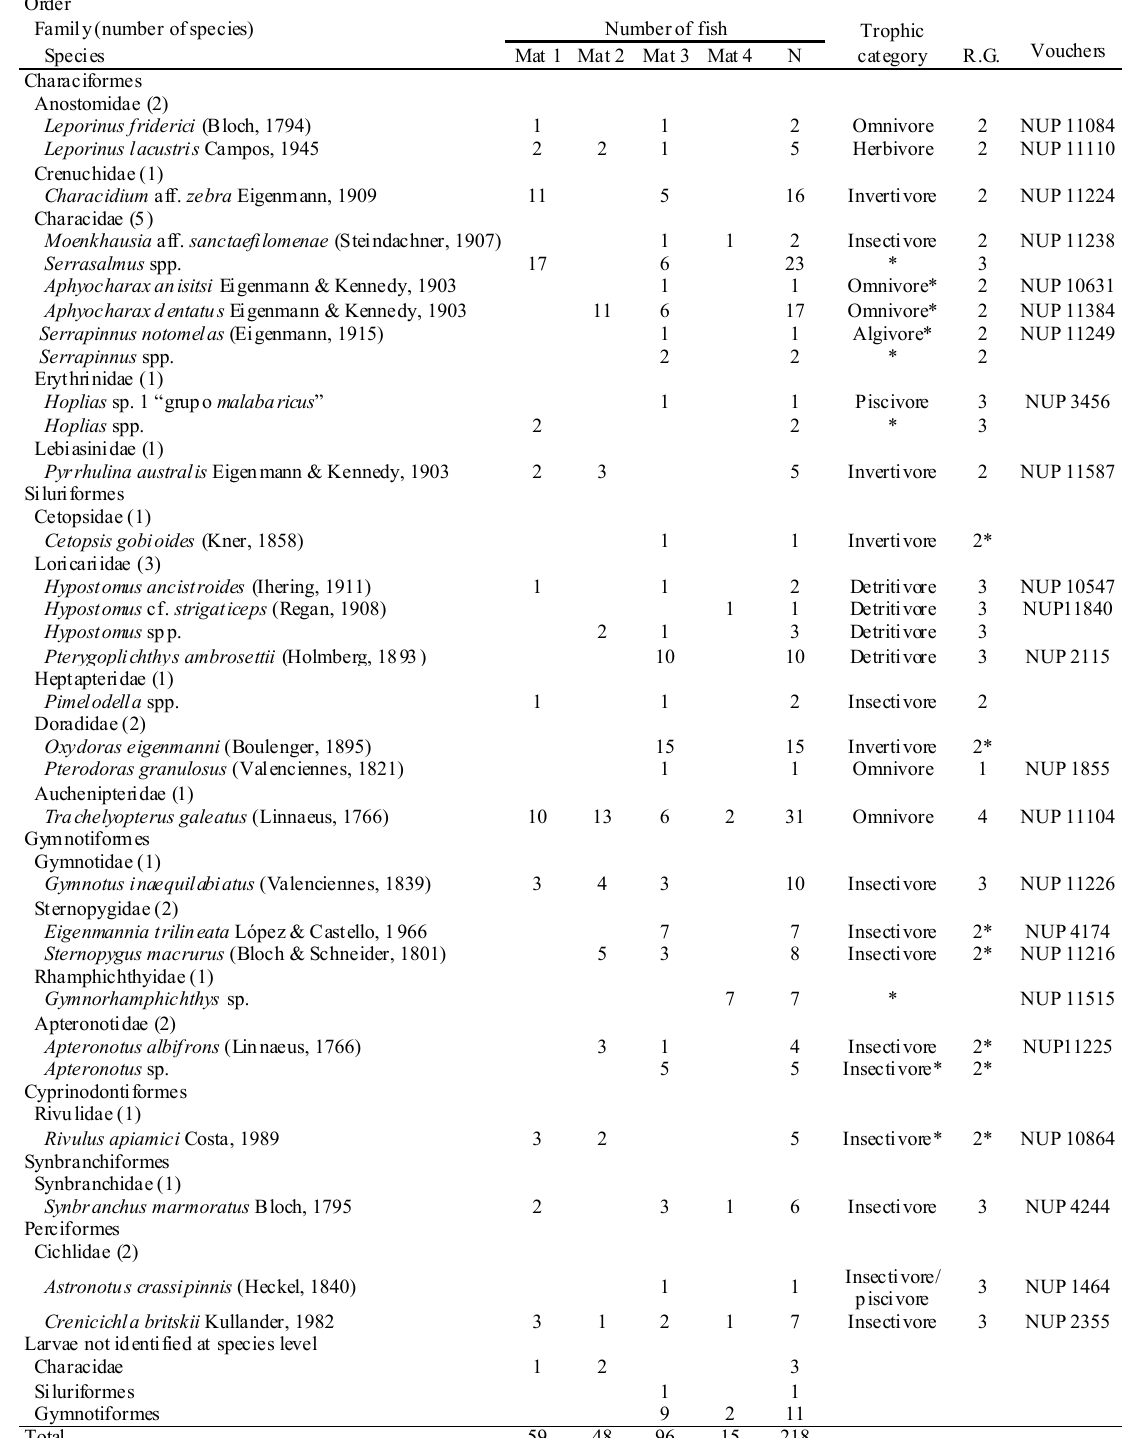
Table 2. Number of fish captured in each of the floating macrophyte mats sampled in the Ivinhema River, Mato Grosso do Sul, Brazil (N: total number of individuals of a given species). It is also presented the trophic categories and reproductive guilds (R.G.) of each species. Reproductive guilds are identified as 1 = long distance migratory species with external fertilization and do not develop parental care; 2 = sedentary or short-distance migratory, external fertilization and no parental care; 3 = sedentary with external fertilization and parental care; and 4 = internal fertilization. * = species with few data available in the